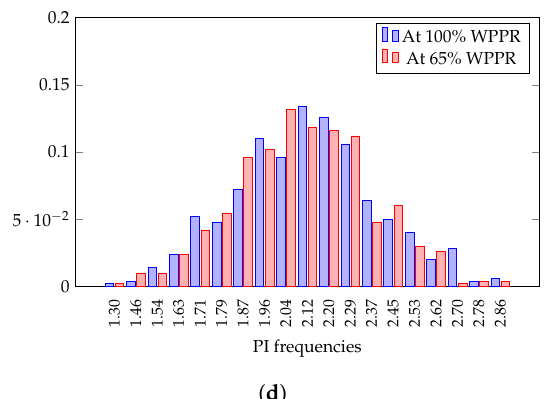
Figure 7. Risk analysis related to the: ( a ) net present value; ( b ) internal rate of return; ( c ) payback period; ( d ) profitability index. Table 12. Financial indicators statistics at 65% and 100%